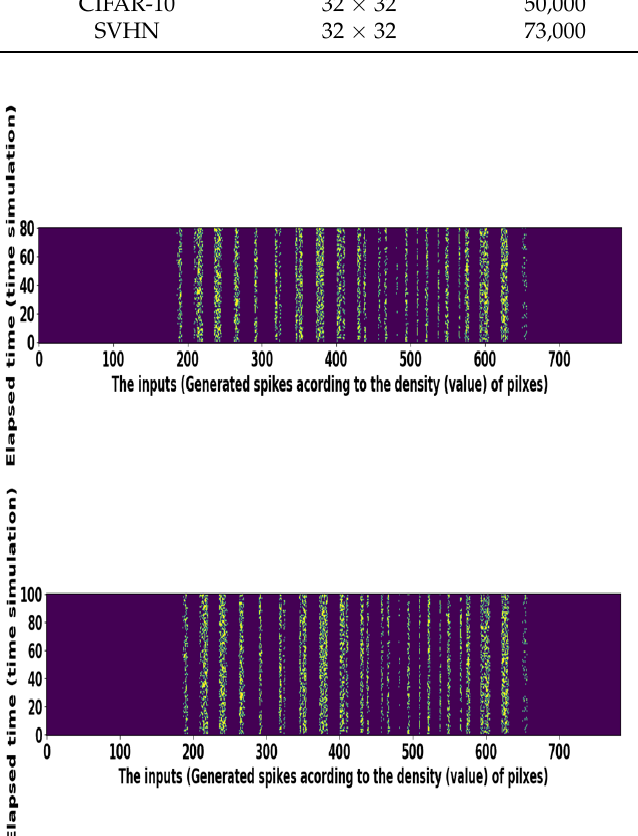
Figure 8. Raster plots of random spike trains taken from the MNIST